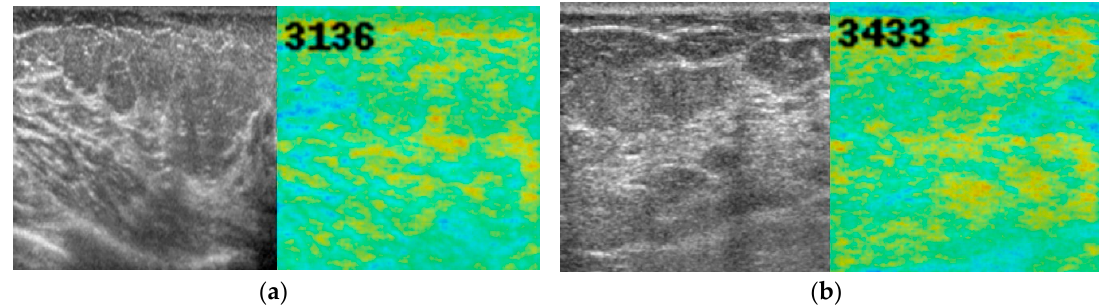
Figure 3. Receiver operating characteristic (ROC) curve. ( a ) ROC curve of normal vs. benign + malignant, ( b ) ROC curve of normal vs. malignant ( c ) ROC curve of normal + benign vs. malignant; and ( d ) ROC curve of benign vs. malignant.